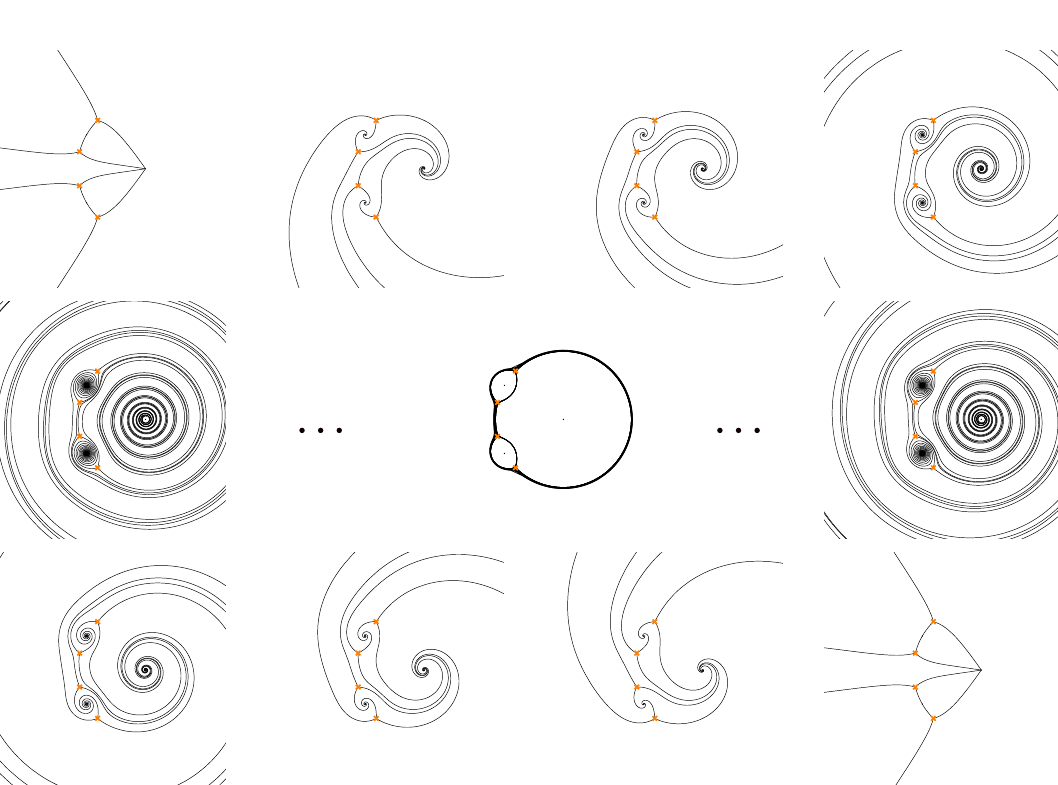
Figure 12. Sequence of spectral networks of the SU(2), N f = 4 theory. The phases begin with sector I as described in (3.22), for phases ranging from # c (cid:0) (cid:25)= 2 (top-left) up to # c (center), and pro- ceeds with phases from sector II as described in (3.25) ranging from # c to # c + (cid:25)= 2 (bottom-right).